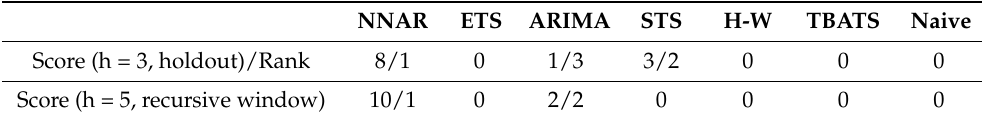
Table 5. Robustness checks: RMSE score of candidate models for holdout out-of-sample forecasting at h = 3 and RMSE for recursive window forecasting at h = 5. NNAR ETS ARIMA STS H-W TBATS Naive Score (h = 3, holdout)/Rank 8/1 0 1/3 3/2 0 0 0 Score (h = 5, recursive window) 10/1 0 2/2 0 0 0 0